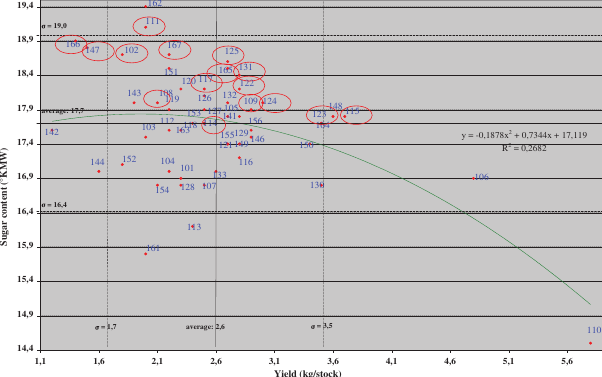
Figure 1. Yield and sugar content of the must of the selected ’Kadarka’ elite stocks (Szekszárd - Parászta field, 2001-2009)